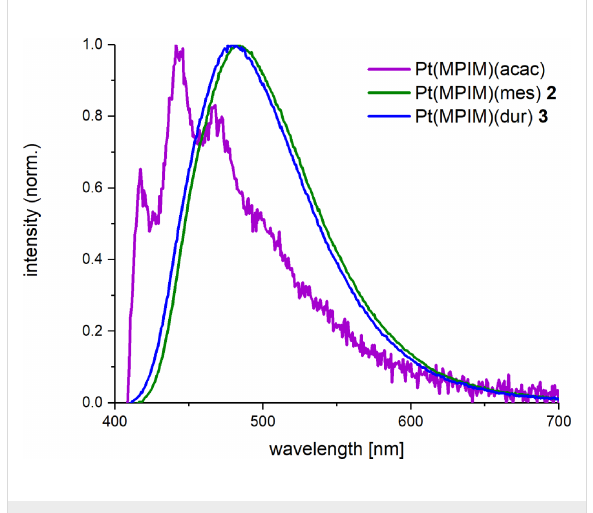
Figure 6: Photoluminescence spectra of 2 and 3 compared to the emission profile of Pt(MPIM)(acac), 2 wt % in PMMA, λ exc = 320 nm.